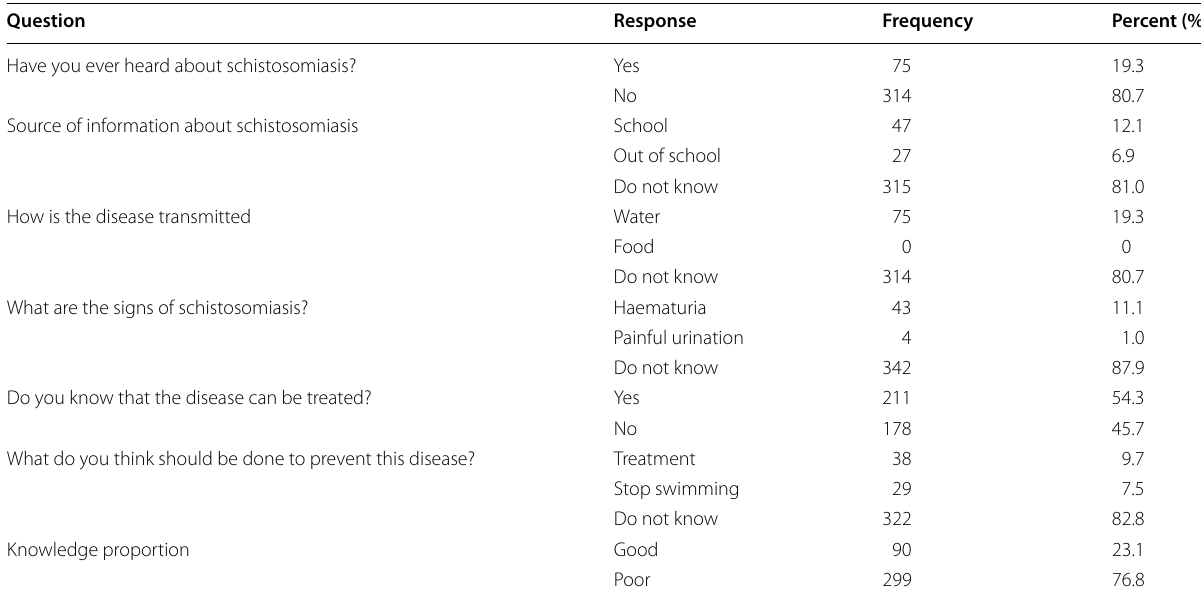
Table 3 Proportion of participants’ awareness of urogenital schistosomiasis Question